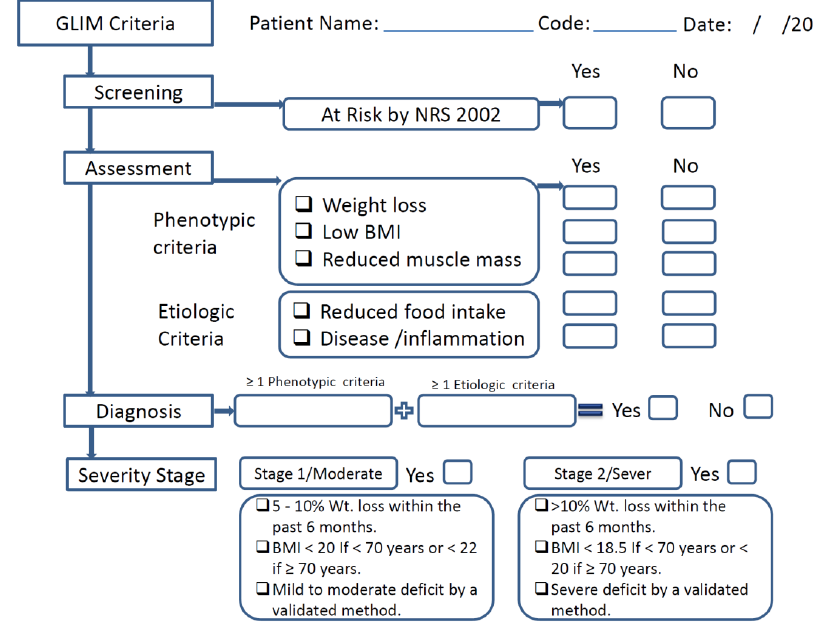
Figure 1. Schematic flow for the use of the GLIM in this study.